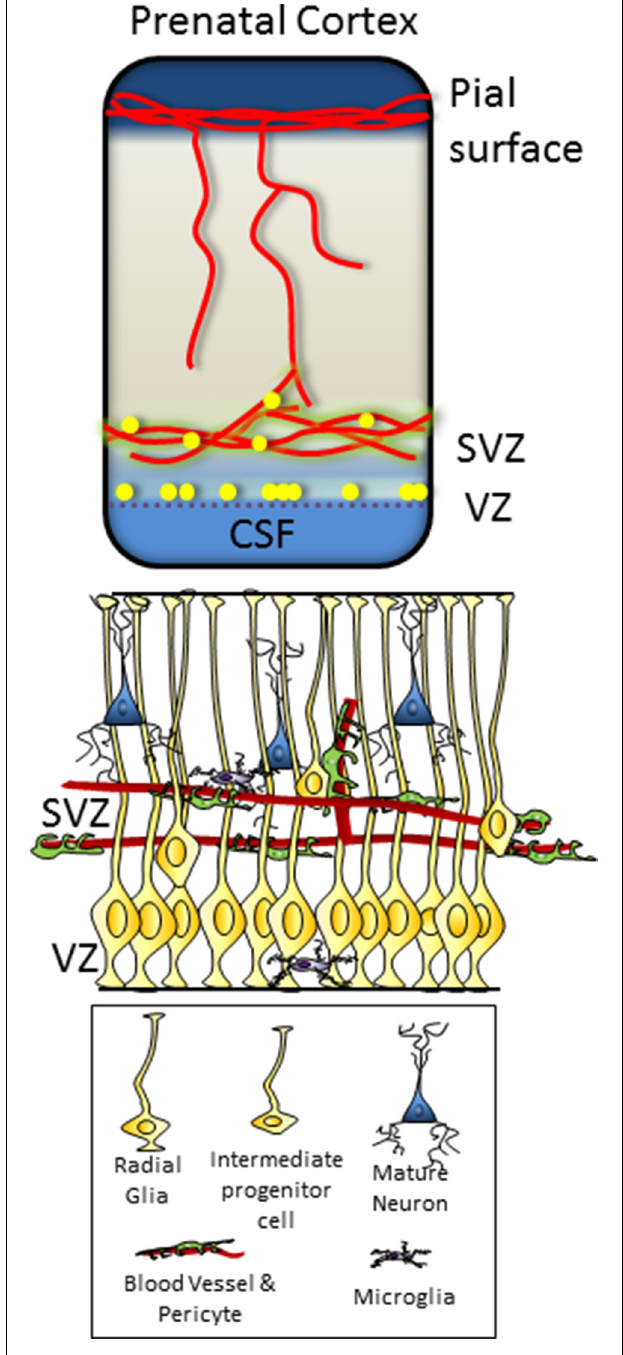
FIGURE 1 | Dorsal telencephalon in the fetus, showing pial and ventricular vascular plexi and the location of the VZ and SVZ progenitor zones. Microstructure and cellular component of the VZ and SVZ illustrated below, with VZ progenitors contacting the ventricular surface of the brain and SVZ progenitors in close contact with the vascular